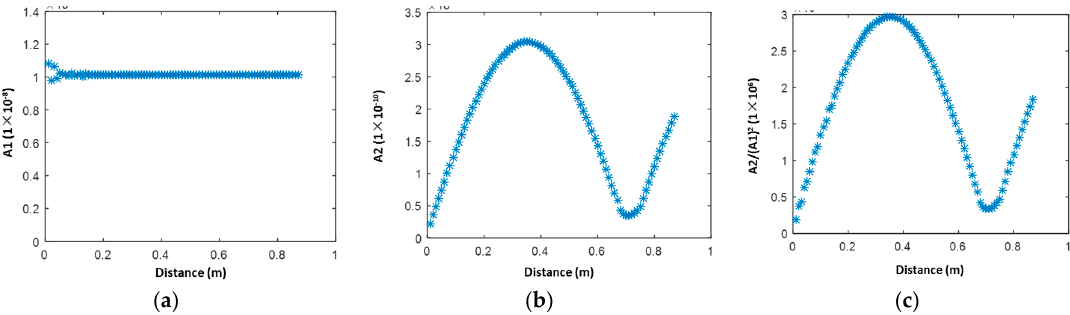
Figure 4. Magnitudes of the S 0 -S 0 mode pair (0.4 MHz mm–0.8 MHz mm) extracted through Short-time Fourier Transform (STFT) in the 2-D simulation model: ( a ) fundamental mode A1; ( b ) second harmonic mode A2; and ( c ) A2/(A1) 2 .